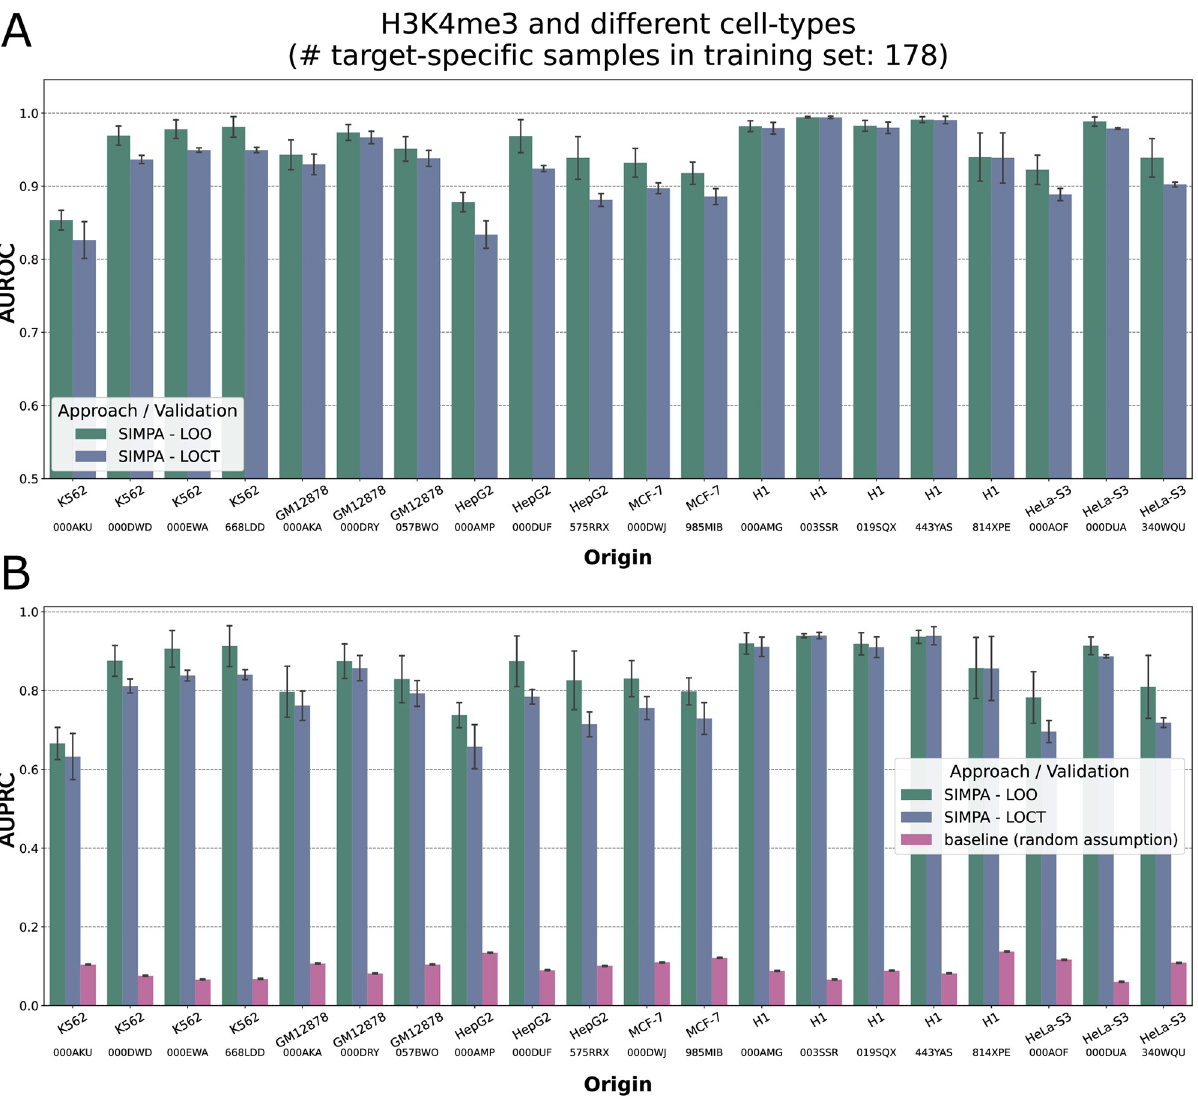
Fig 2. Performance on simulated sparse profiles in different cell-types. A . For simulation, a full human single-cell profile (origin profile) is defined by a full bulk profile and the corresponding sparse single-cell profile is defined by the down-sampled bulk profile. Compared to real data, the simulations allows us to test SIMPA on full profiles related to a large variety of ChIP protein targets and biosamples. Using the origin profile as the validation set of true binding interactions, the area under ROC-curve (AUROC in y-axis) describes the capability of SIMPA to accurately impute the sparse profile and recapitulate the origin. The bars describe the mean AUROC and the error bars describe the standard deviation across multiple applications on sparse sets with different sizes. SIMPA was validated with two strategies, the default leave-out origin (LOO; origin profile excluded from the training set) and the extreme leave-out cell-type (LOCT; all experiments with the same cell type than the origin profile are excluded from the training set). The x-axis labels indicate the cell-type of the origin profile and additionally the ENCODE accession to show which of the experimental dataset was used as origin. B . Same as in A but using the area under precision-recall curve (AUPRC in y-axis) as performance measure. The pink bars show the class balance (fraction of positives in the class feature) representing the random assumption as baseline to be expected from a primitive classifier that randomly assigns the class values (according to [29]). Note, the sampled bins, that simulate a sparse single-cell profile and are expected to be known before imputation, were completely excluded before computing area under the curve values. https://doi.org/10.1371/journal.pone.0270043.g002 experimental datasets that are most similar to the origin (experimental profiles with same pro- tein target and same cell-type, see Supplementary Note 3 in S1 File for details). All compari- sons excluded bins used as input for SIMPA. Results show that for most of the simulations ( > 95%) the imputed profile is closer to the origin profile, hence single-cell specific (Fig 3A).